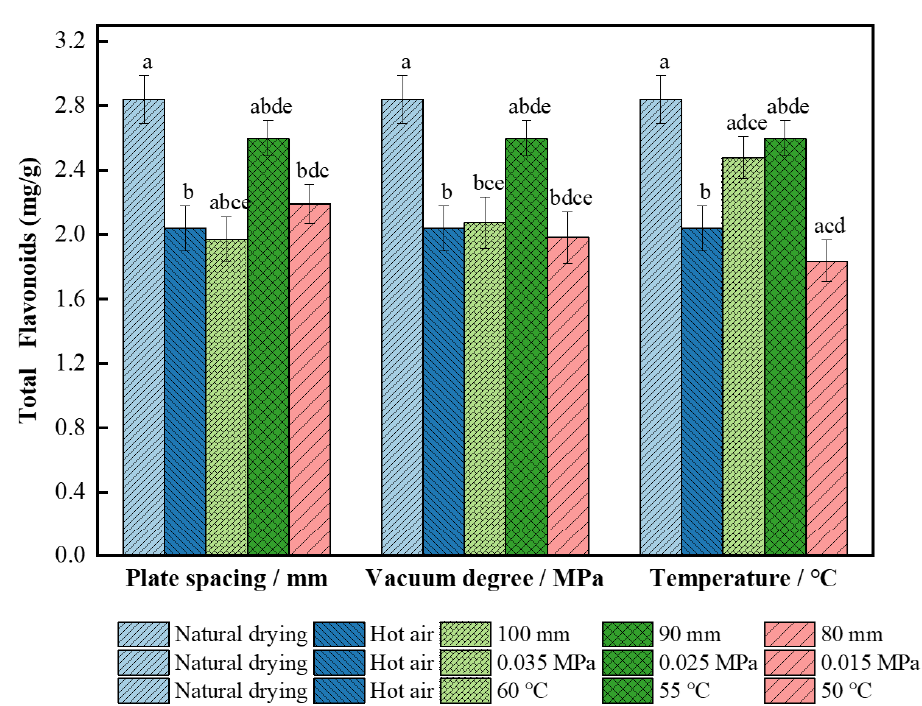
Figure 7. Total flavonoids content of L. barbarum under different drying conditions. Significant differences are represented by different letters ( p <